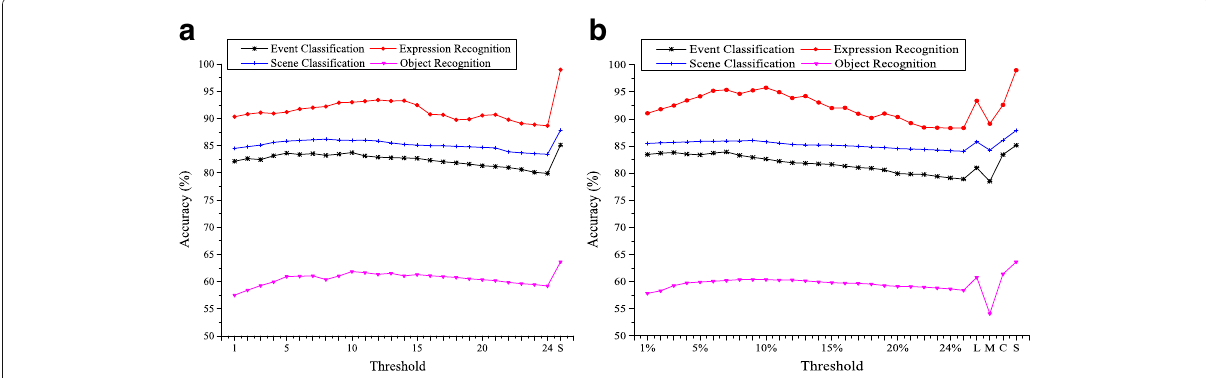
Fig. 7 Demonstration of object recognition, scene classification, event classification, and expression recognition accuracy using different thresholds. a Accuracy of different constant thresholds. b Accuracy of different dynamic thresholds (i.e., percentage of the center pixel as threshold). All the results are generated considering ternary pattern in CENTRIST framework. Noteworthy, L (threshold used in LGP [16]), M (median threshold used in LAID [42]), S (SQRT of center pixel), and C (cube root of center